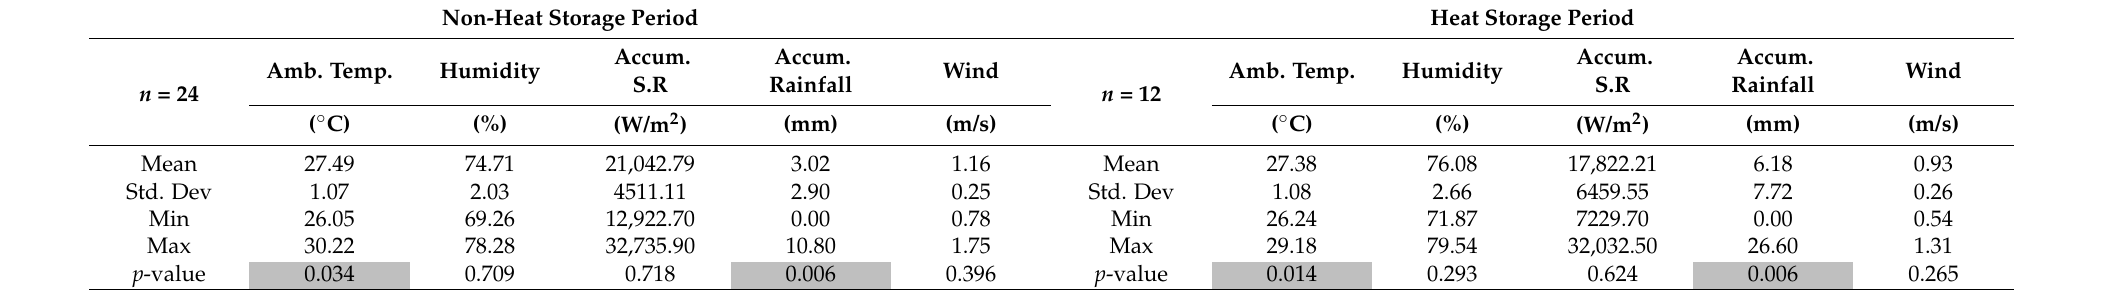
Table 3. Descriptive statistics for weather variation divided into non-heat storage period and heat storage period. Non-Heat Storage Period